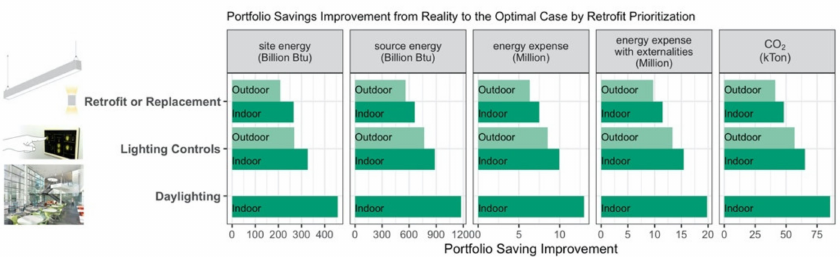
Figure 15. The benefits of prioritizing lighting sub-actions (1 billion Btu = 1055 billion joules).